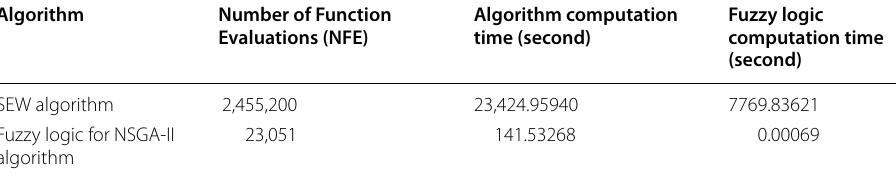
Table 8 Comparison of computation time of SEW and NSGA-II algorithms for decision-making by fuzzy logic